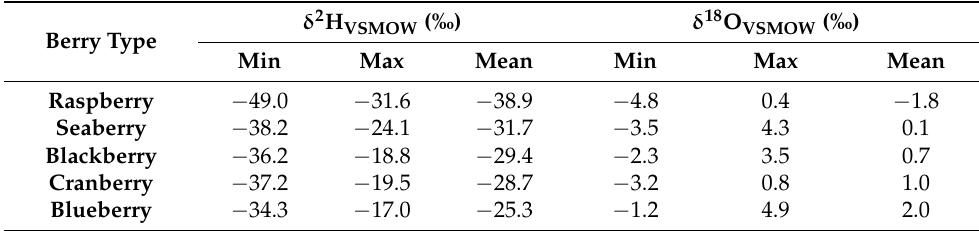
Table 1. Isotopic signature of 2 H and 18 O for studied samples.